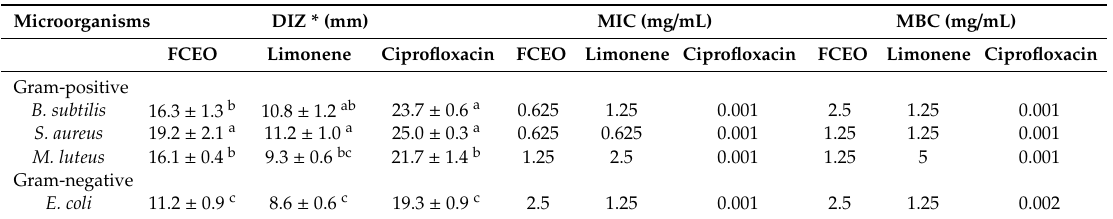
* Values represent means of three independent replicates ± SD. Di ff erent letters within a column indicate statistically significant di ff erences ( p < 0.05) for